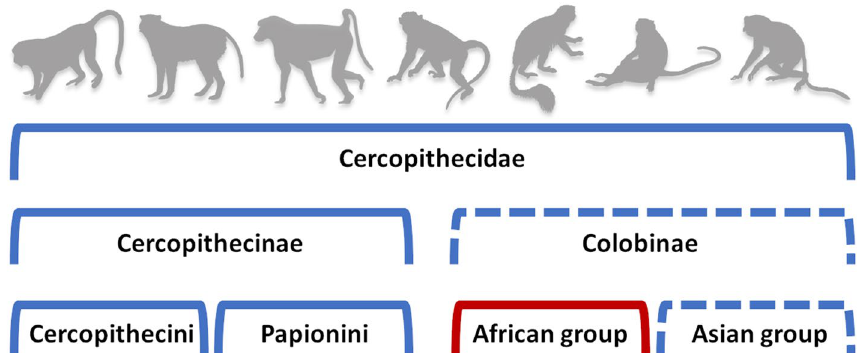
Figure 2. Summary of evolutionary processes across Cercopithecidae as detailed in Table 1. Blue indicates rejection of drift (and possibly diversification by natural selection), and red specifies groups for which the null hypothesis of genetic drift has not been rejected. Dashed lines depict levels in the phylogeny with varying genetic drift versus selection results for the full skull, cranial, and mandibular analyses. Silhouettes taken from Phylopic.org. Image of Cercopithecus by Kai R. Casper (https:// creat iveco mmons. org/ licen ses/ by/3.